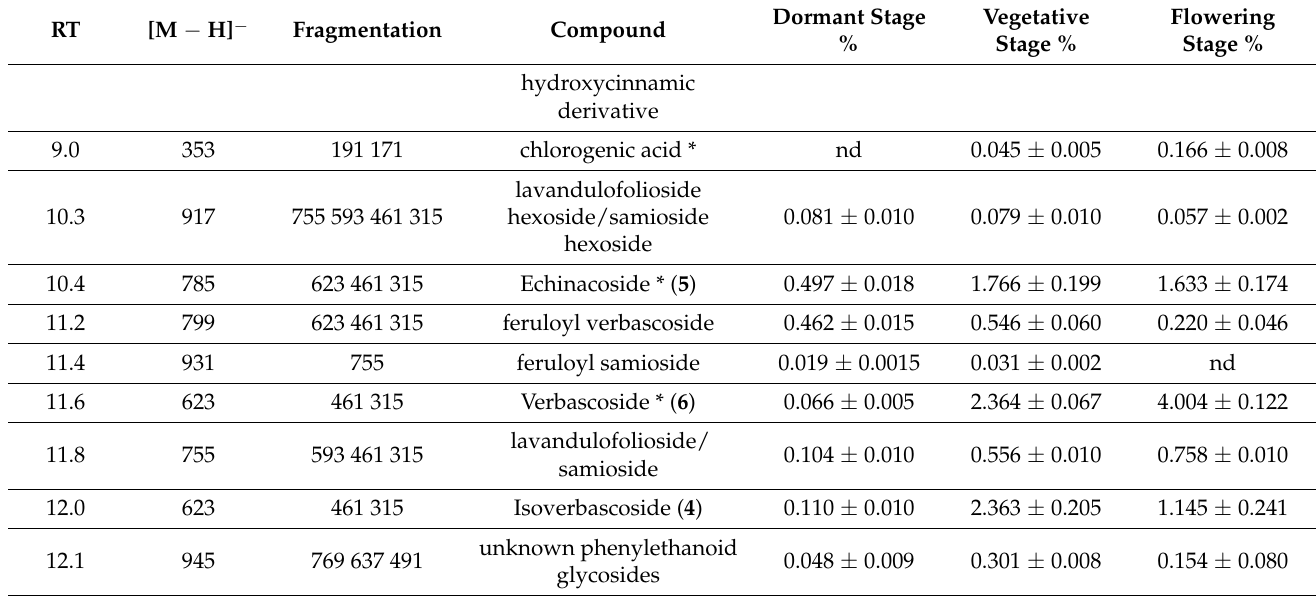
Figure 2. Enlargement of the HSQC-DEPT spectra of R. michauxii extracts at the flowering stage in MeOD 4 . Table 2. Qualitative–quantitative composition of hydroxycinnamic derivatives, O-glycosylated flavonoids, C-glycosylated flavonoids and gallic acid derivatives in R. michauxii extracts at the dormant, vegetative and flowering stages. Results are expressed as mean ± standard deviation (n = 4). RT: retention time, nd: not detected, § : quantified by NMR. * identification Table 1. 1D and 2D NMR correlation of the main classes of constituents of R. michauxii extract at the flowering stage. * partially overlapped signals.